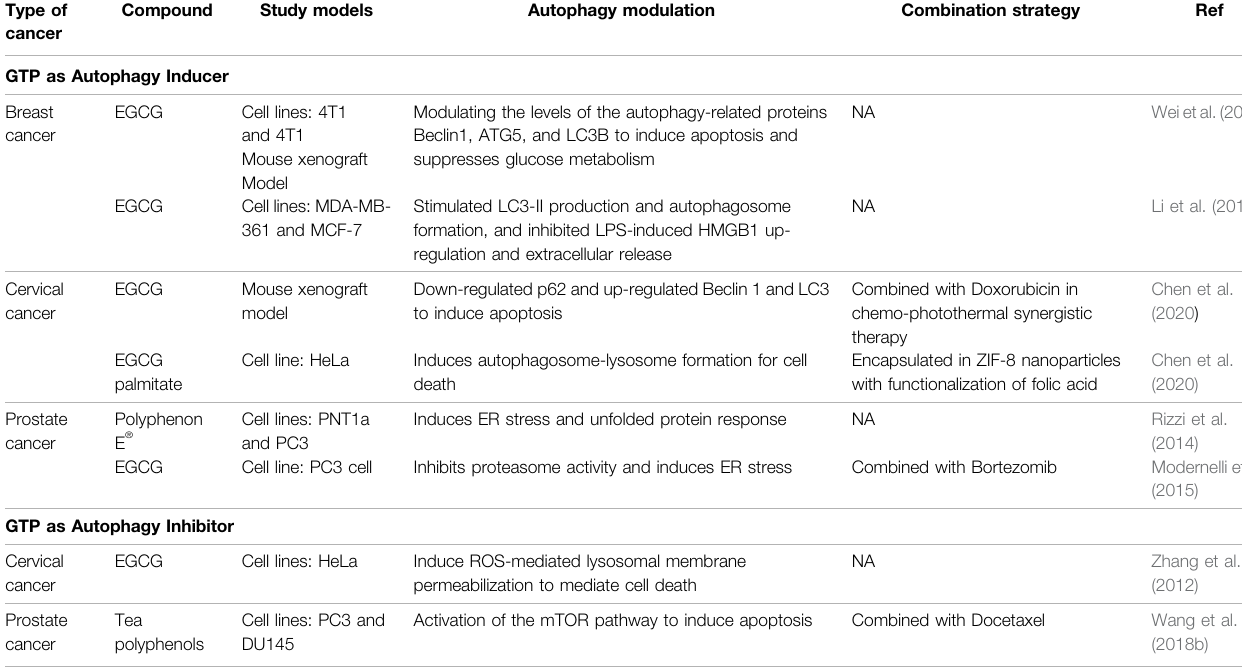
TABLE 4 | Green tea polyphenol (EGCG) as autophagy modulator in cancer study from 2011 to 2022 January. Type of cancer